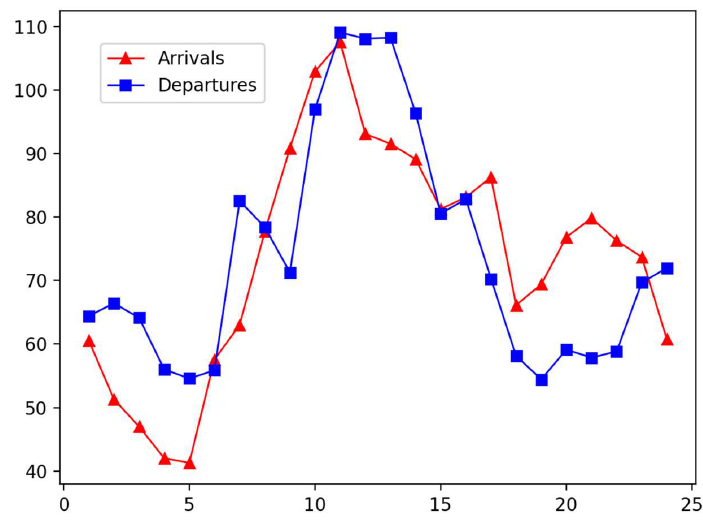
Figure 9. The line chart of the ship arrivals and departures at Shanghai Port for one day.